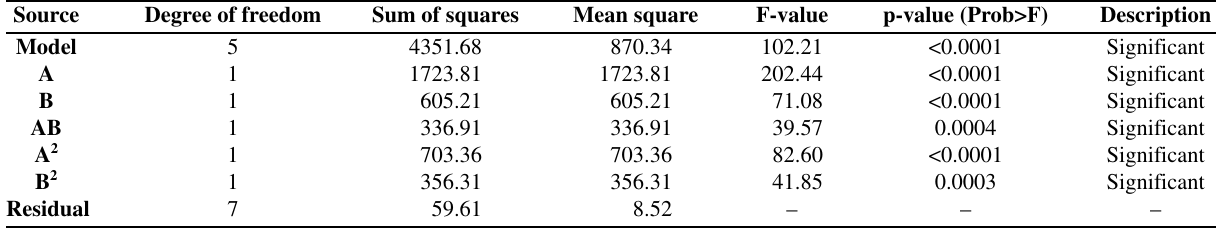
Table 7. Regression analysis (ANOVA) of RSM of MG Source